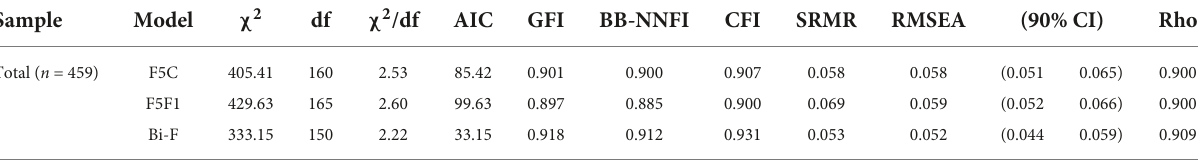
TABLE 4 Confirmatory factor analysis of RNSS for the total sample. Fit indices are estimated using the robust method. Sample